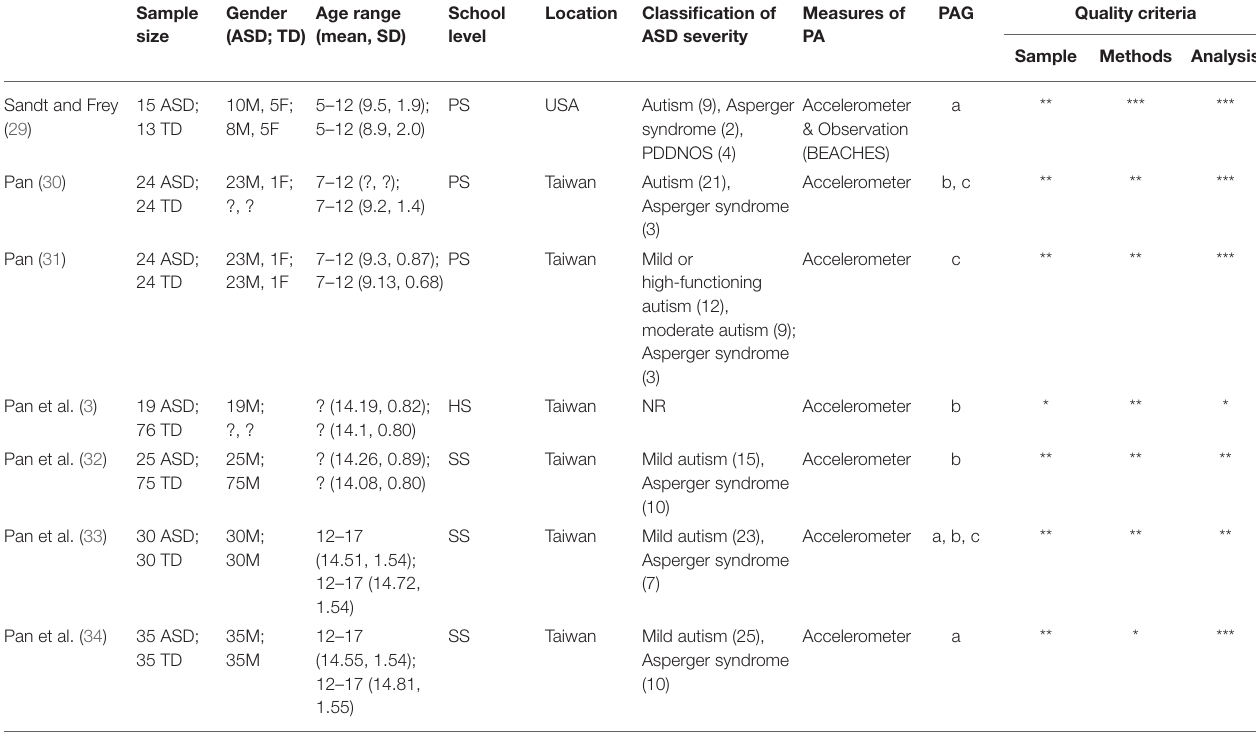
TABLE 1 | Summary of the participants’ characteristics of included studies. Sample